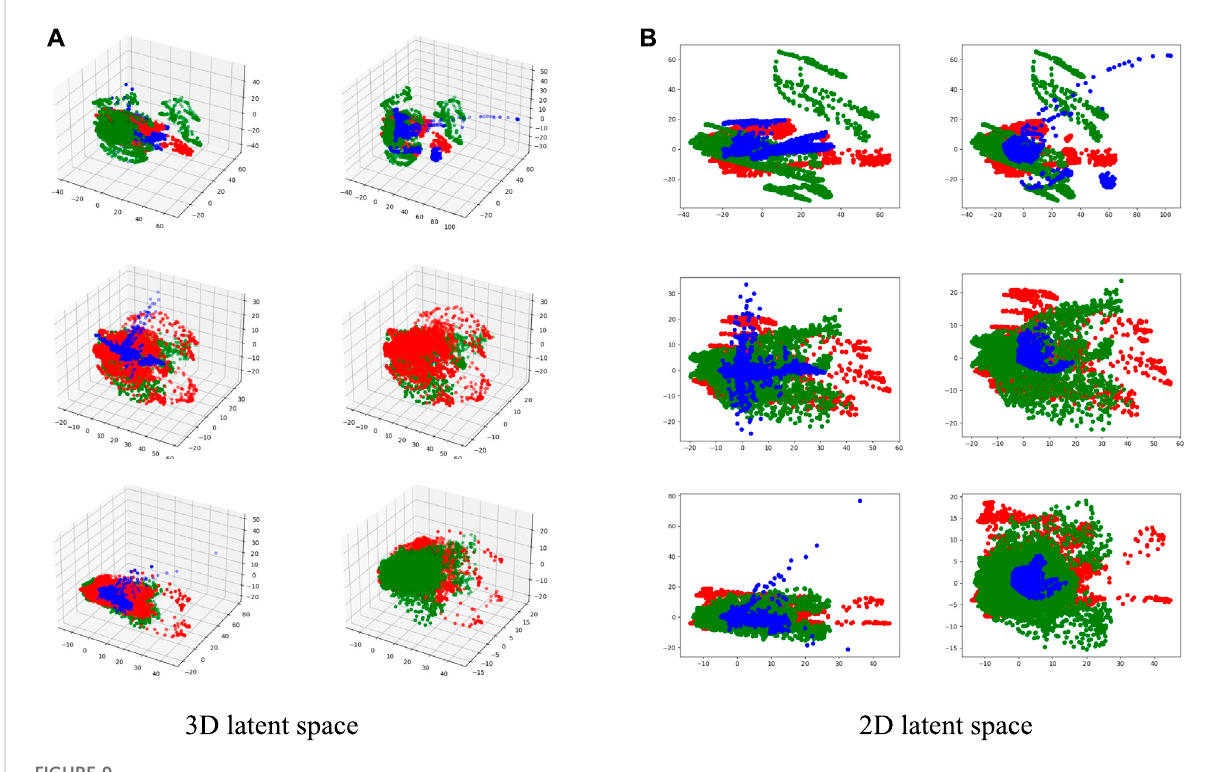
FIGURE 9 Visualizations of the unique and commonfeatures in 2D and 3D latent spaces. Red and green points represent theunique features of two input modalities, and blue points represent the common features. In (A) and (B) , the left column represents MAFFB i in the fusion network, and the right column represents MAFFB 6 − i in the GAN-based network, i = 1, 2, 3.